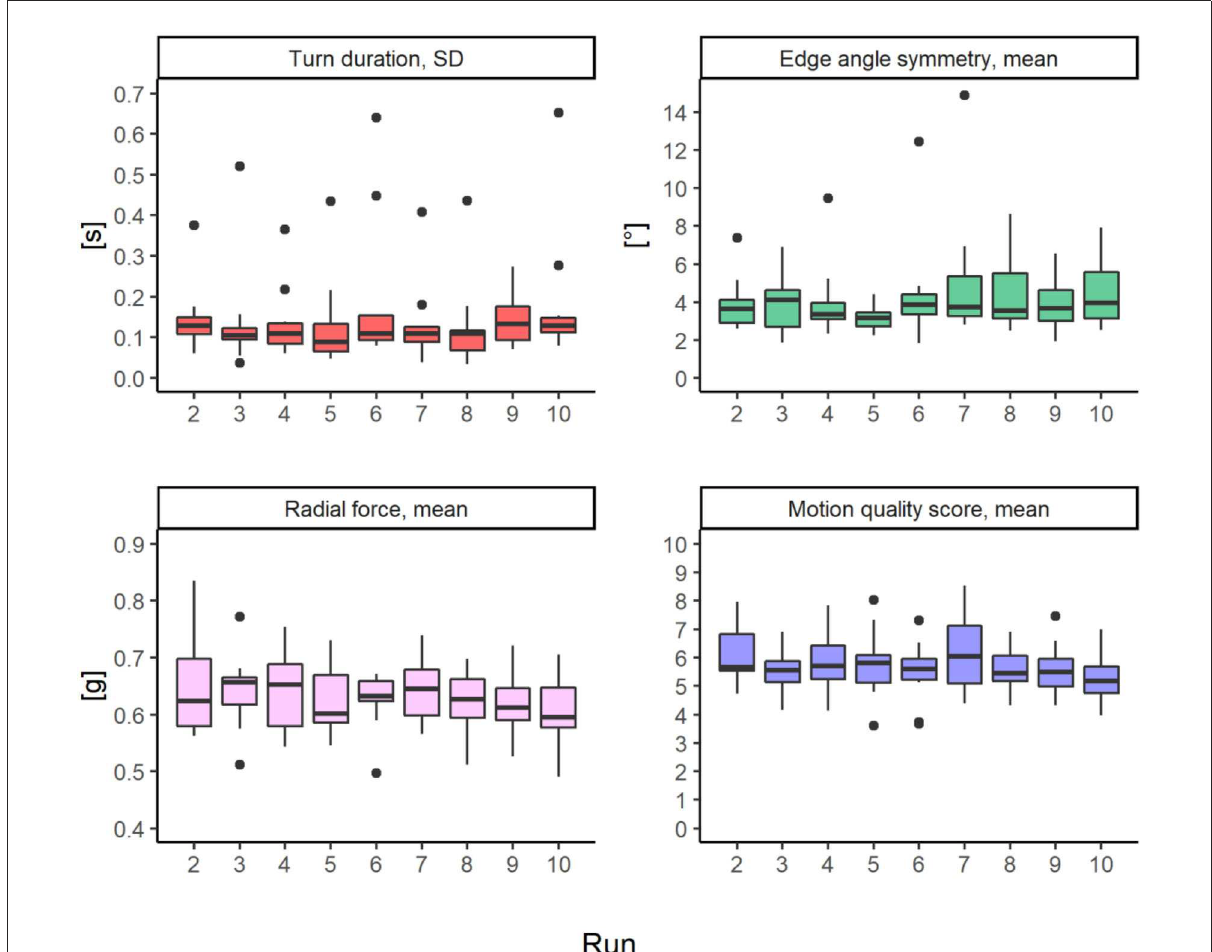
FIGURE4 Boxplots including outliers (1.5 times of the interquartile range) indicated as black dots of biomechanical parameters ( n = 10) per